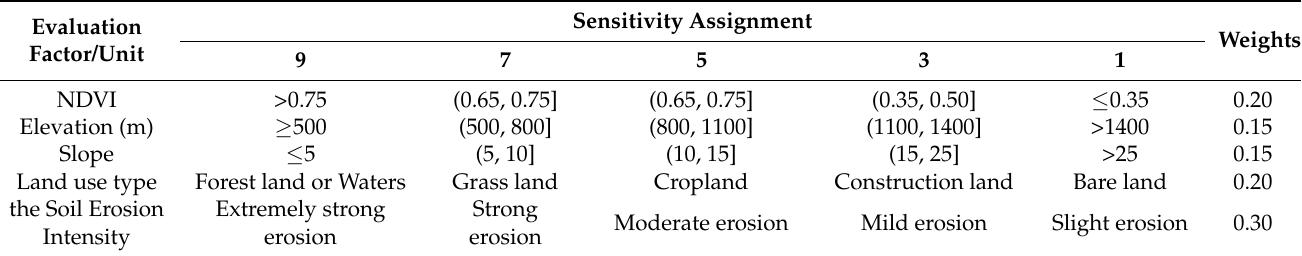
Table 3. Classification and weight of ecological sensitivity evaluation